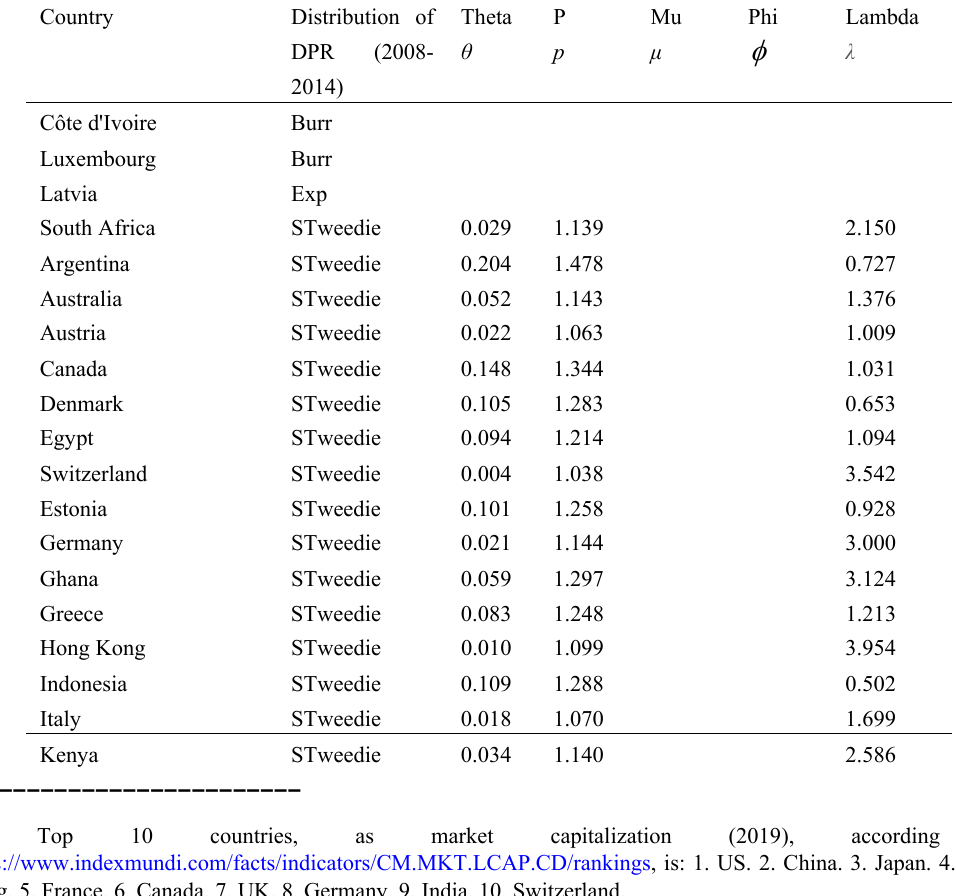
16 Top 10 countries, as value of stocks traded as percent in GDP (2019), according